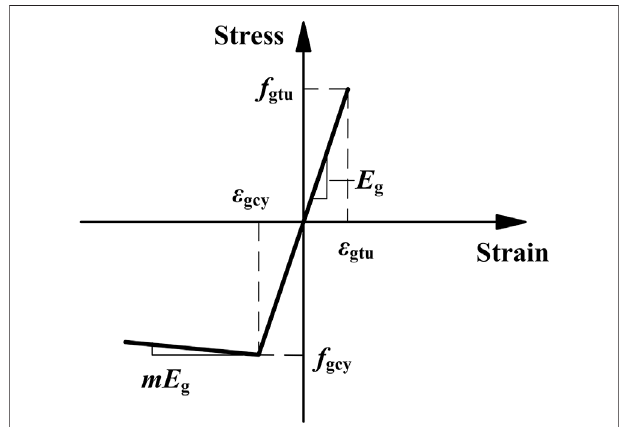
FIGURE 11 | Stress – strain relationship for glulam in the theoretical model (Bazan, 1980; Buchanan, 1990).